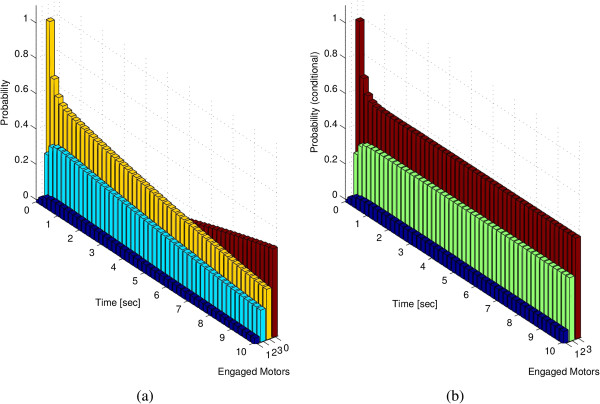
Probability of having 1, 2, 3 or 0 motors engaged on the microtubule as a function of time t  (a). Probability of having 1, 2, 3 motors engaged on the microtubule as a function of time t under the condition that there is at least one motor engaged (b). The probability of having no engaged motors converges to 1 as time goes to infinity. Observe, instead, that a constant probability distribution is reached in case (b) where it is assumed that at least one motor is engaged.